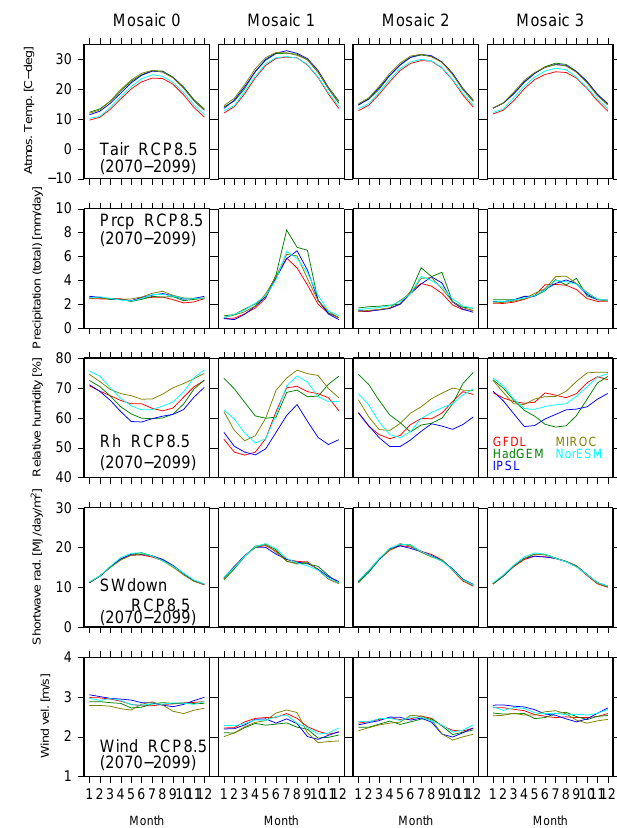
Figure 8. Monthly anomalies with respect to the ensemble mean of five GCMs for 1971–2000. The results are aggregated over each land use. The anomaly in each GCM is indicated in different colors: (red) GFDL, (green) HadGEM, (blue) IPSL, (dark yellow) MIROC and (light blue) NorESM. The panels from top to bottom show the relative humidity, potential evapotranspiration, evapotranspiration, irrigation water demand (IWD) and irrigation water consumption from rivers